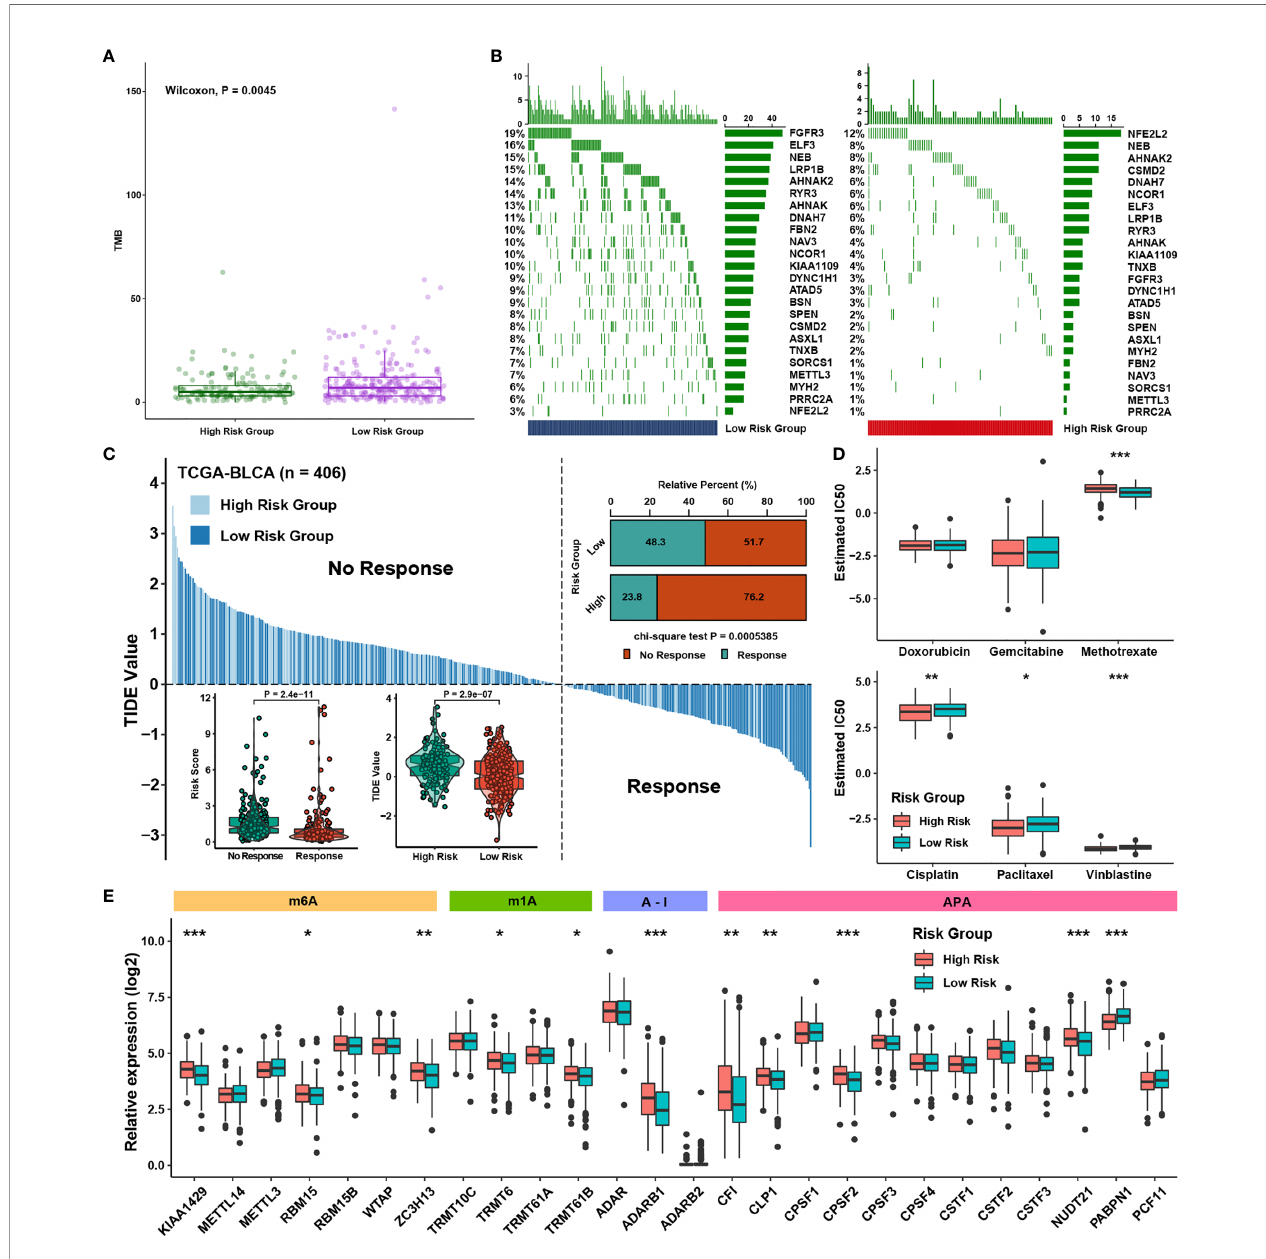
FIGURE 6 | Potential therapeutic value of the writer-related gene signature. (A) The abundance of TMB in different risk groups. (B) Waterfall plot of tumor somatic mutations in patients with high risk scores and low risk scores. The columns represent individual patients. The upper bar plot shows TMB, and the number on the left indicates the mutation frequency in each gene. (C) The TIDE value of BLCA samples in TCGA is shown for different risk score groups, and the chi-square test used to assess signi fi cant differences is shown in the upper right. The risk scores and TIDE values in different response groups and risk groups are shown in the bottom left. (D) The estimated IC50 values of six commonly used chemotherapy drugs are shown in different risk groups. (E) The expression of 26 writer genes is shown in different risk groups. The asterisks represent the statistical P-value (*P < 0.05; **P < 0.01; ***P <